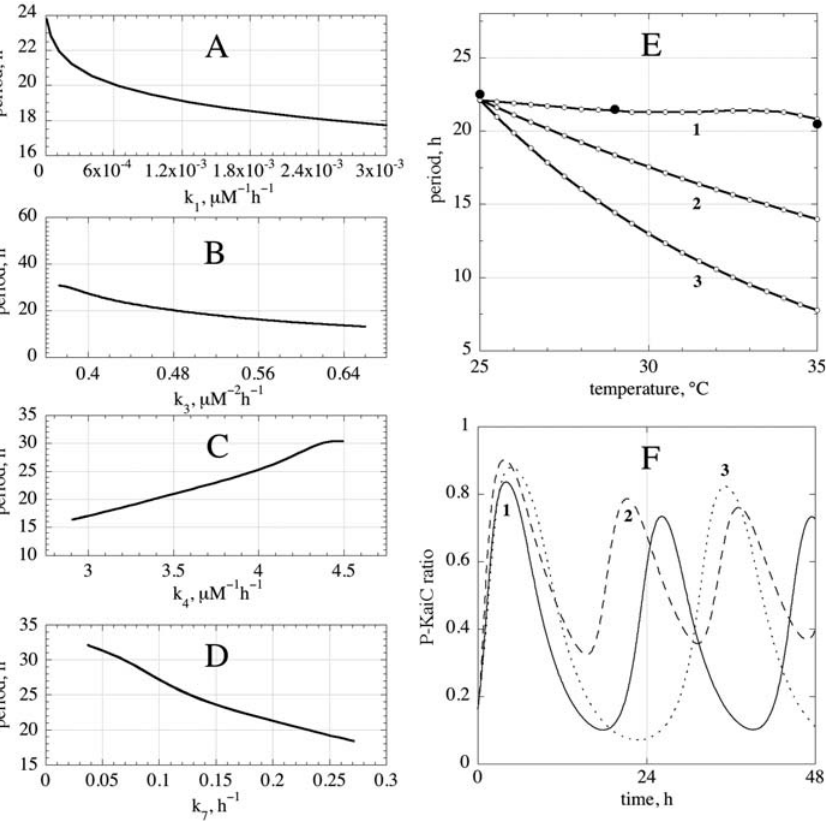
Figure 5. Parameter Sensitivities and Temperature Compensation (A–D) Period sensitivity analyses by varying the following selected rate constants (A) k 1 , (B) k 3 , (C) k 4 , and (D) k 7 . As k i is varied, the other rate constants are kept constant at their initial values as described in Figure 2. (E) Temperature dependence of the period. Open circles show calculations, and solid circles show experimental results replotted from [1]. Each rate constant obeys the Arrhenius equation, k i ¼ A i exp ( (cid:1) E i /RT), where E i is the activation energy, R is the gas constant, and T is the temperature in Kelvin. A i is the pre-exponential factor, which is also treated as a constant. Initial values of rate constants (Figure 2) are defined at 25 8 C, and the period lengths are calculated for temperatures between 25 8 C and 35 8 C. (1) Temperature compensation (Q 10 ¼ 1.06) using the following activation energies: E 1 ¼ 40 kJ/ mol, E 2 ¼ 35 kJ/mol, E 3 ¼ 28 kJ/mol, E 4 ¼ 43 kJ/mol, E 5 ¼ 40 kJ/mol, E 6 ¼ 25 kJ/mol, and E 7 ¼ 25 kJ/mol. (2) All activation energies have the average value (34 kJ/mol) from the calculation in (1) showing a Q 10 of 1.58. (3) All activation energies are 80 kJ/mol, and the oscillator shows a Q 10 of 2.85. (F) Dependence of period and P-KaiC ratio as a function of KaiABC* stability mimicking KaiC mutant behaviors. (1) Rate constants are as in Figure 2 ( ‘‘ wild-type behavior ’’ ); (2) Decreased P-KaiC ratios amplitudes and shorter periods ( ‘‘ short period KaiC mutant behavior ’’ ) are observed for a more stable KaiABC* complex relative to (1): k 4 ¼ 2.3 l M (cid:1) 1 h (cid:1) 1 , k 5 ¼ 4.5 h (cid:1) 1 , k 6 ¼ 1.0 h (cid:1) 1; and (3) Long-period KaiC mutant behavior is observed when the KaiABC* complex is more stable compared to (1): k 4 ¼ 4.0 l M (cid:1) 1 h (cid:1) 1 , k 5 ¼ 1.5 h (cid:1) 1 , and k 6 ¼ 0.8 h (cid:1) 1 .